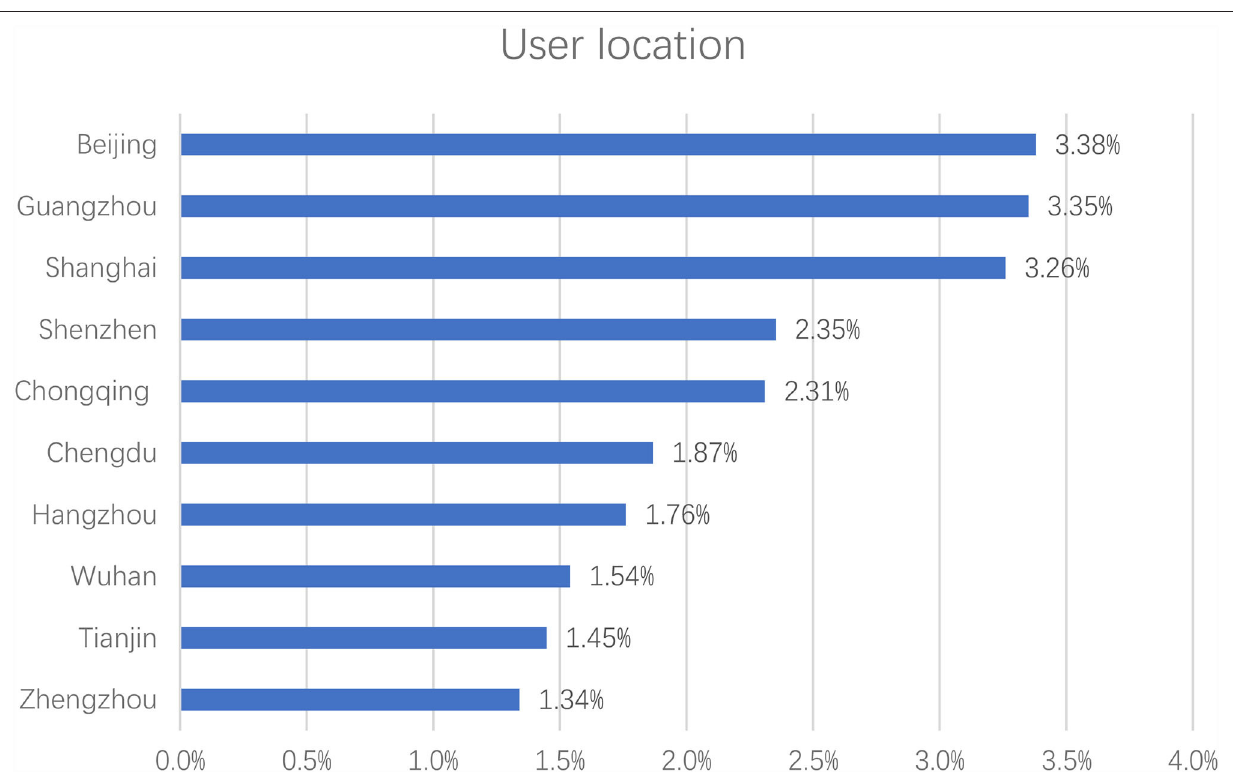
FIGURE 6 | Top 10 location of the hashtag “#national mask campaign#” participants.